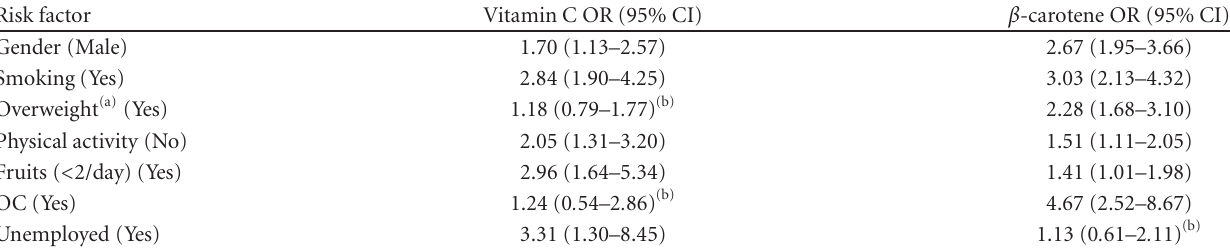
Table 3: Risk factors related to vitamin C and β -carotene deficiency. Results are expressed as OR with 95% confidence intervals.